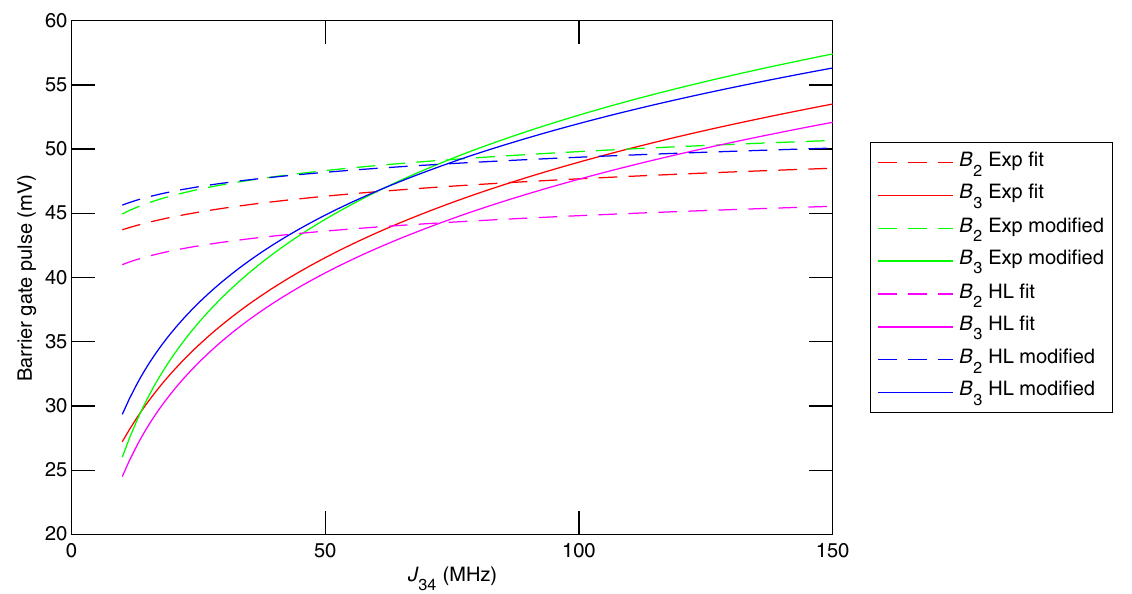
FIG. 5. Comparison of gate voltages predicted by initial and modified fits for both the exponential and corrected HL models. The red solid and dashed lines are the gate voltages for B 2 and B 3 generated by the exponential model for the three-spin exchange-oscillation data presented in the main text. The gate voltages were calculated using the parameters we obtain after fitting the calibration data. However, as discussed in the main text, these gate voltages generate exchange couplings that are too small. Therefore, we modify the model parameters as discussed in the main text, and the actual gate voltages we used are shown in the green solid and dashed lines. The magenta and blue lines show the gate voltages predicted by the initial and modified parameter sets for the correct HL model for the same experiment. The modified parameters for both the correct HL model (blue lines) and the exponential model (green lines) generate rather similar gate